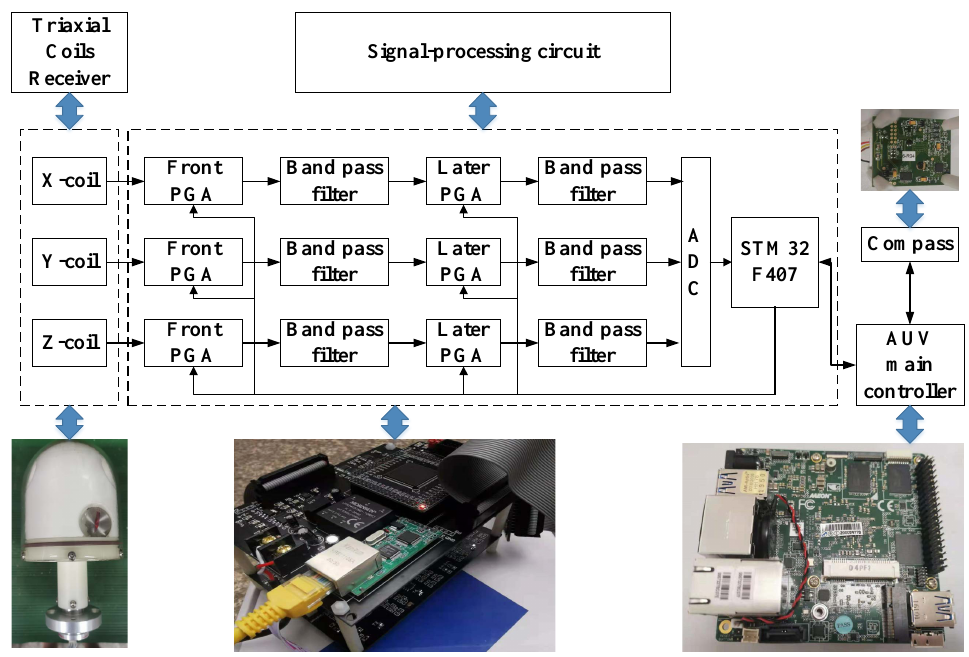
Figure 12. Configuration of the electromagnetic receiver.